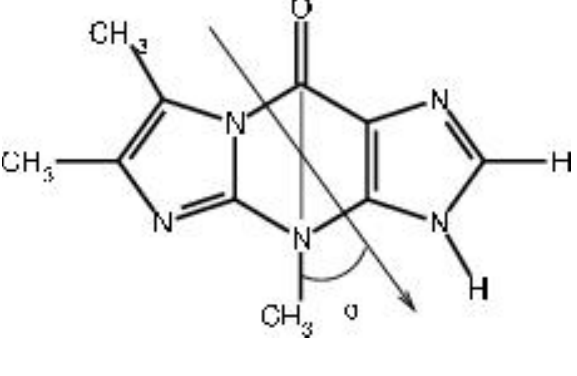
Figure 3. A scheme for describing the angle between the electric dipole moment vector and the molecular reference axis in the molecular plane.